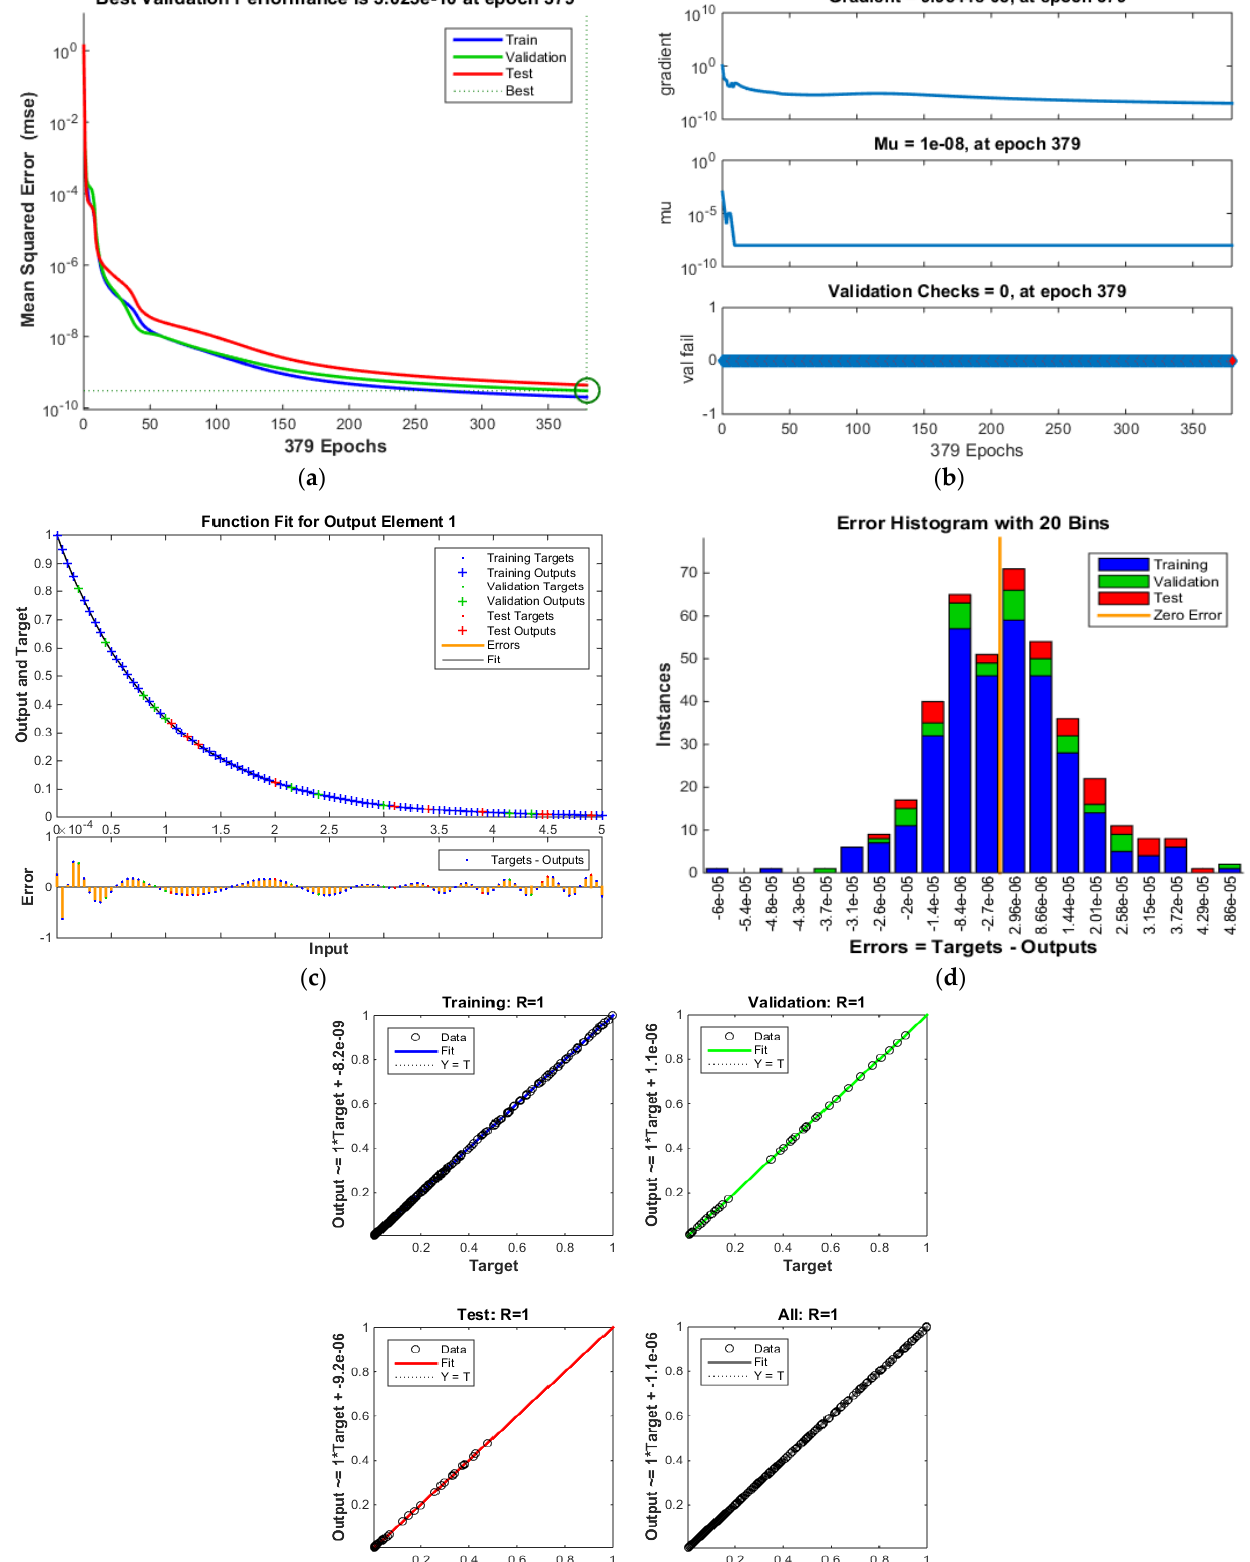
Figure 8. Graphic representation for designed LMT-ABPNN for solving cases of 𝑀 for 𝜃(𝜂) of MHD-SGFM. ( a ) MSE Result, ( b ) Results of the transition state, ( c ) Fitness of the curve, ( d ) Histogram for error analysis, ( e ) Regression.